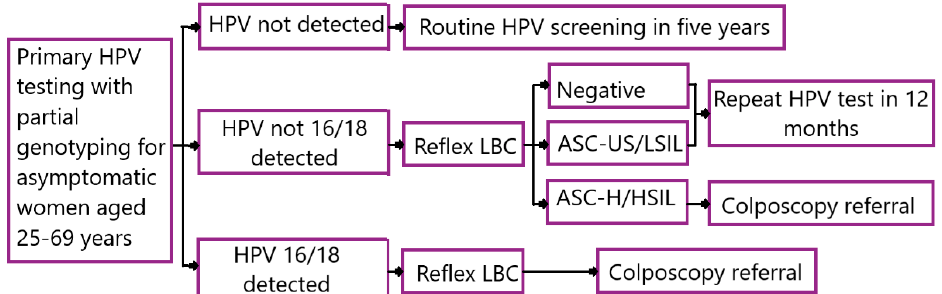
Figure 1. The Australian model of early screening of precancerous cervical lesions (Reprinted from Ref. [15] (do not require permission)). LBC stands for liquid-based cytology; ASC-UC, atypical squamous cells of undetermined significance; ASC-H, atypical squamous cells cannot exclude high- grade squamous intraepithelial lesions; LSIL, low-grade squamous intraepithelial lesion; HSIL, high-grade squamous intraepithelial lesion.